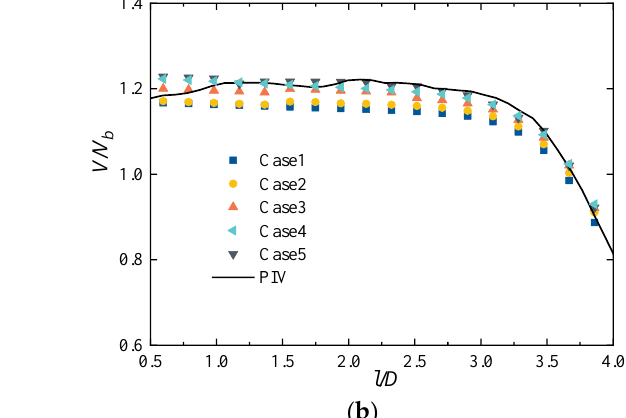
Figure 2. Computational grid generation and independence verification: ( a ) calculation grid of oblique submerged jet; ( b ) analysis of grid independence.